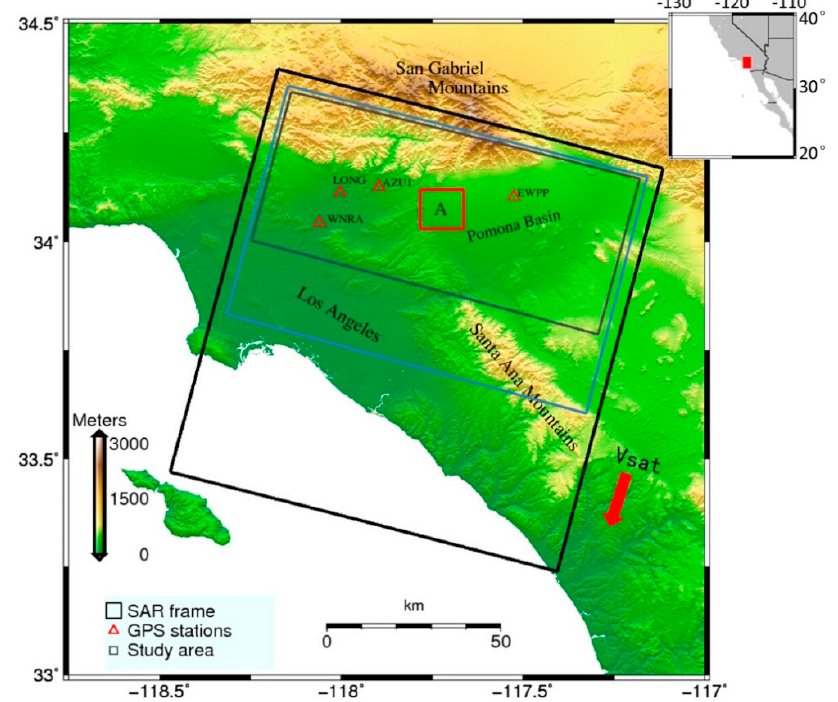
Figure 1. Data coverage for the study region. The area in black rectangle is the footprint of the whole Envisat image. The gray rectangle represents our study area and an experimental region A is denoted by red rectangle. The wider study area used to test turbulent effects is denoted by the blue rectangle. The red triangles represent the locations of GPS sites. The background is the SRTM DEM. Table 1. Parameters of Envisat ASAR images.